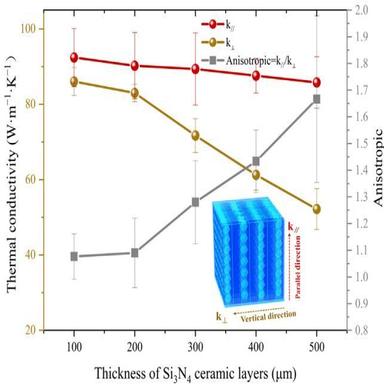
Thermal conductivity of layered composites in directions parallel and perpendicular to layer orientation and the anisotropy.